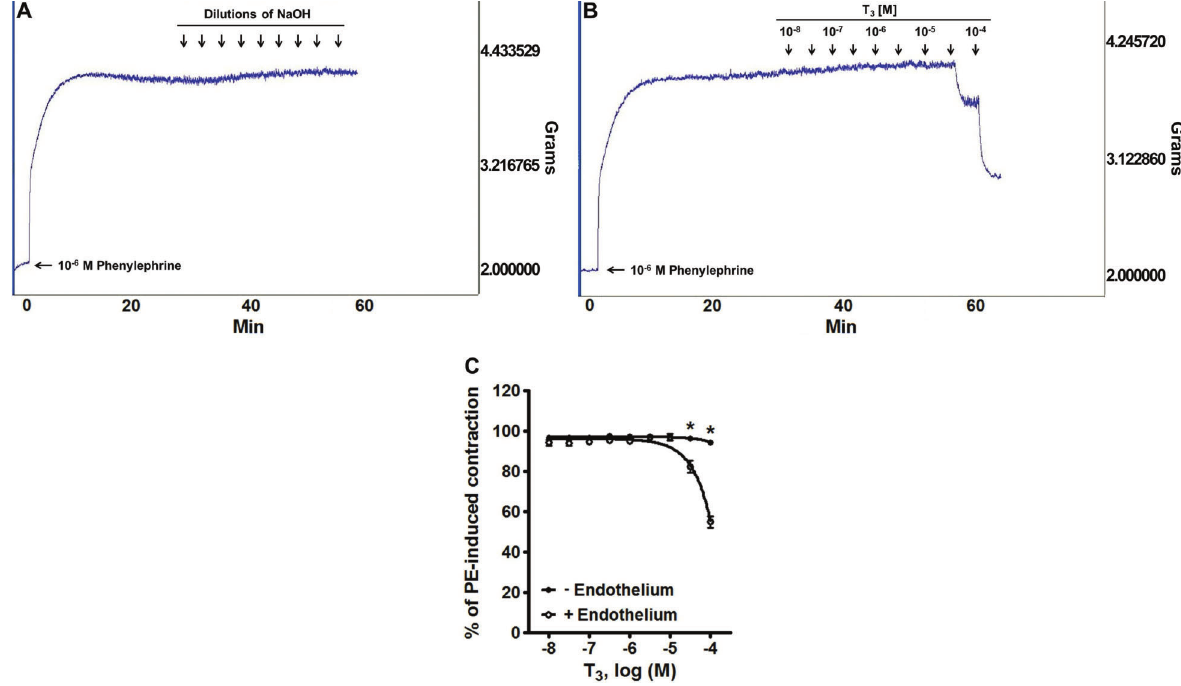
Figure 1. Original experimental tracings illustrating the in vitro effect in phenylephrine (PE)-precontracted rat aortic rings produced by the application of: A , dilutions of NaOH (vehicle of T 3 ), B , 10 -8 – 10 -4 M T 3 . A T 3 -induced vasorelaxant response can be seen at the highest concentrations of this hormone. Similar results were obtained in all assays (n=8). Endothelial denudation blocked the vasorelaxation produced by higher concentrations of T 3 in PE-precontracted rat aortic rings ( C ). Data are reported as means ± SE (n=8 for each group). *P o 0.05 vs control (two-way